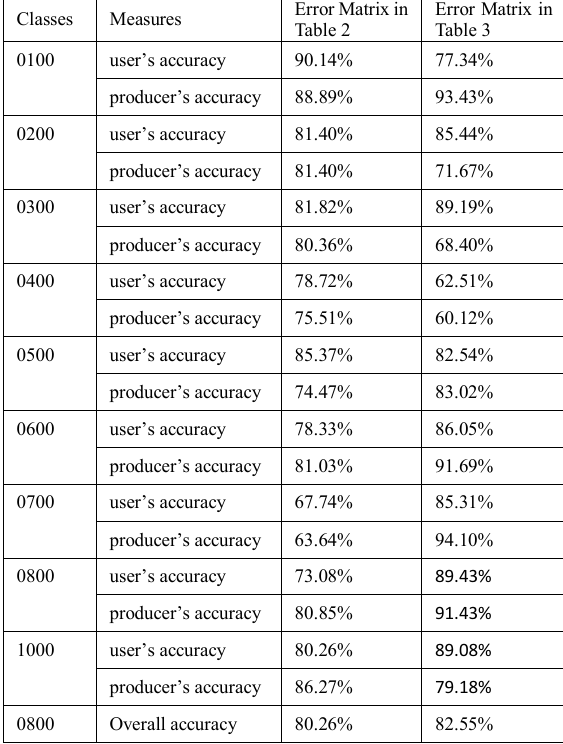
Table 4. Accuracy indexes based on table 2 and table